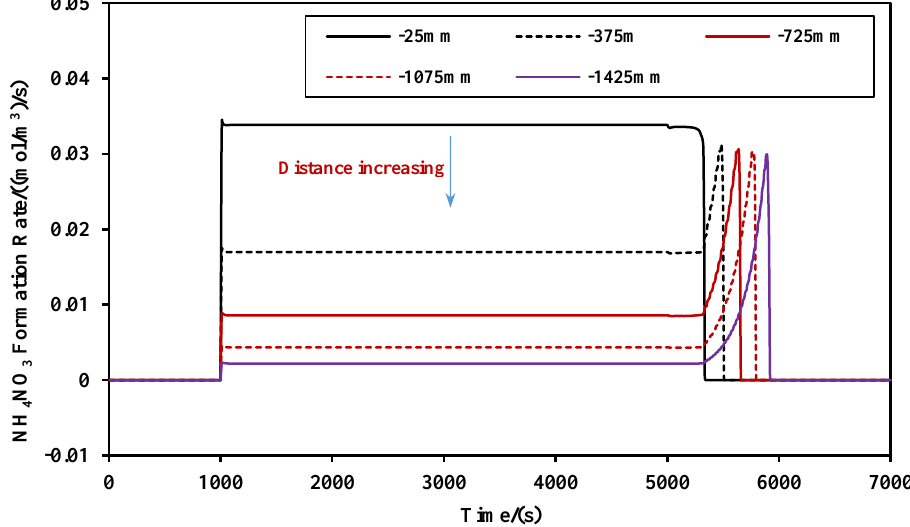
Figure 6. The relationship between the NH 4 NO 3 formation reaction rate and the change of time. ( T = 150 °C, NO 2 /NO x = 0.25).